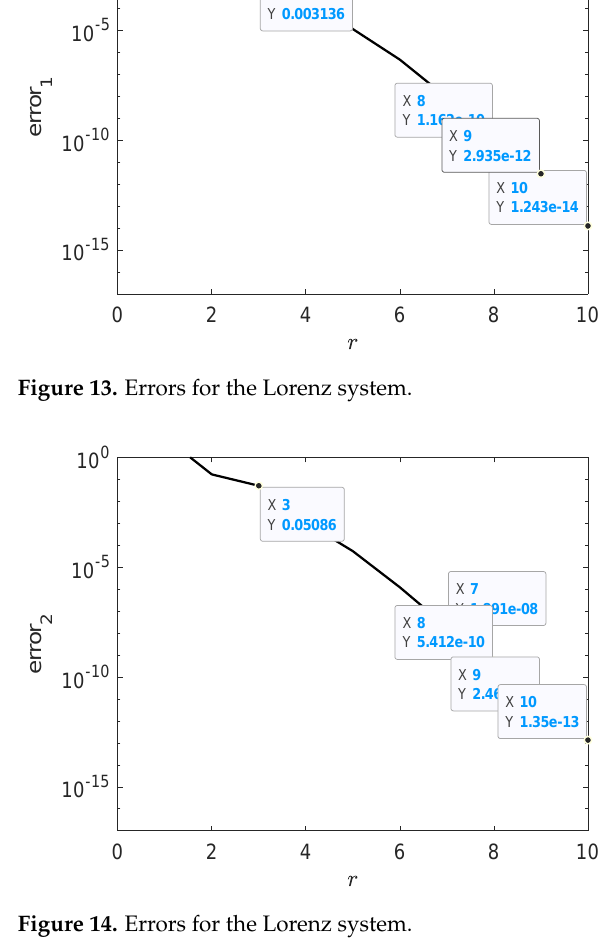
Figure 14. Errors for the Lorenz system.